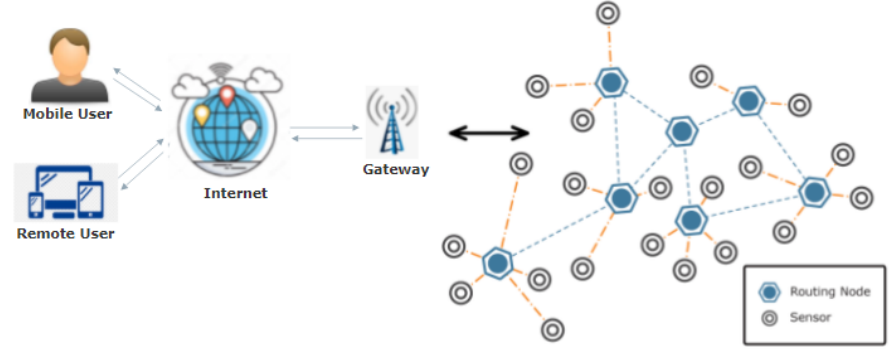
Figure 1. Architecture of wireless sensor network (WSN).